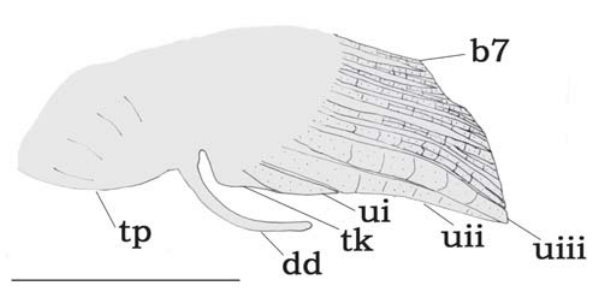
Fig. 26. Male modified anal fin of Tatia gyrina , INPA 20971, 28.0 mm SL. Left side lateral view. Abbreviations: b7 , branched seventh ray; dd , deferent duct; tp , thick secretory pouch; tk , tegumentary keel; ui , unbranched first ray; uii , unbranched second ray; uiii , unbranched third ray. Scale bar = 1